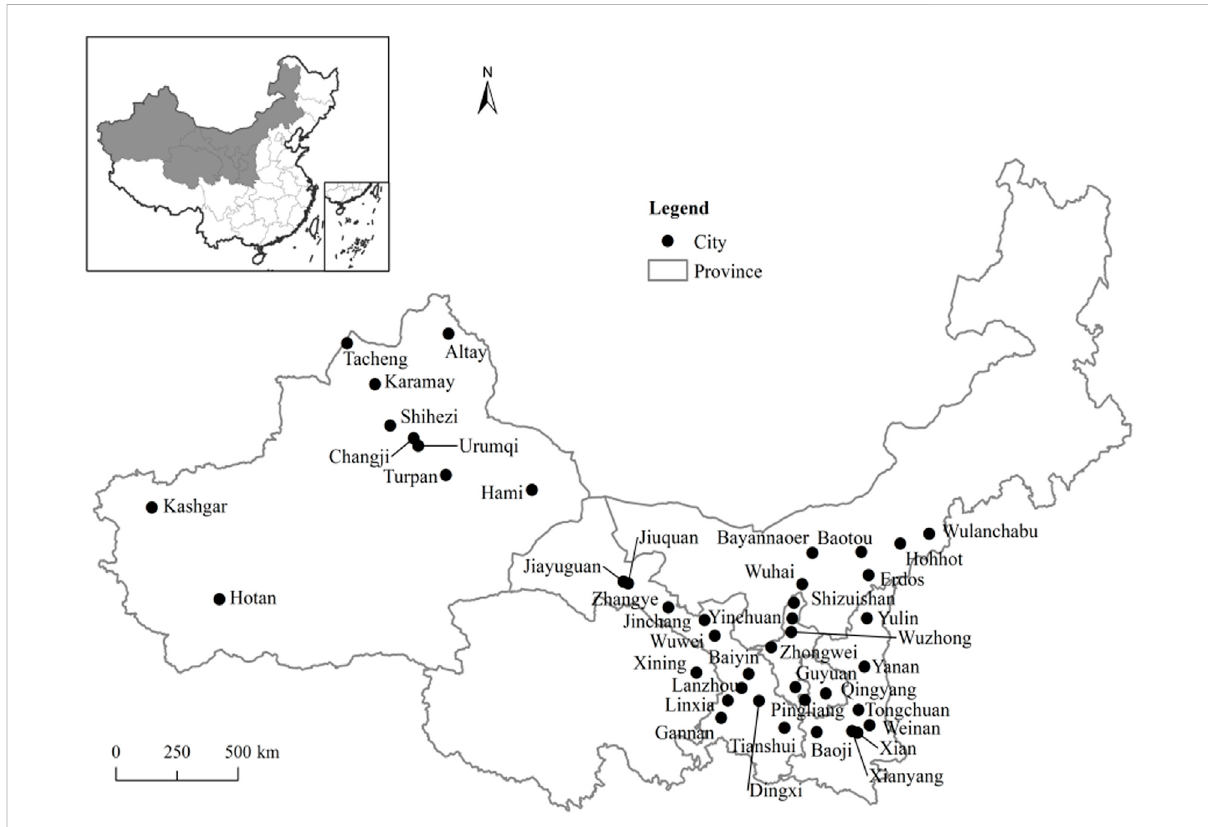
FIGURE 1 Location of study area. Note: The data of the map come from the National Geomatics Center of China (Available at ngcc. cn/ngcc/html/1/391/ 392/16114.